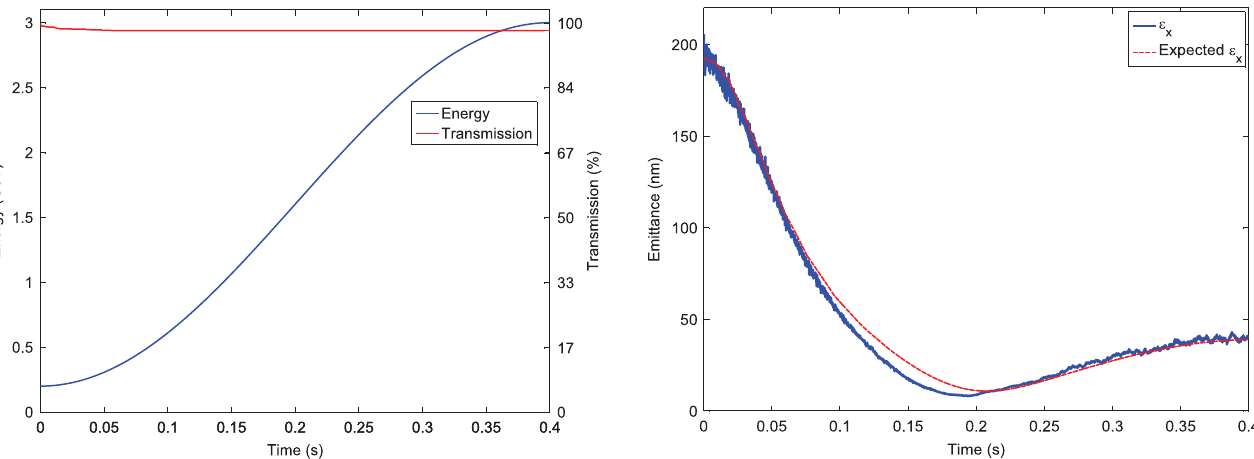
FIG. 13. The energy and transmission vs time for the booster ramp with a single bunch.